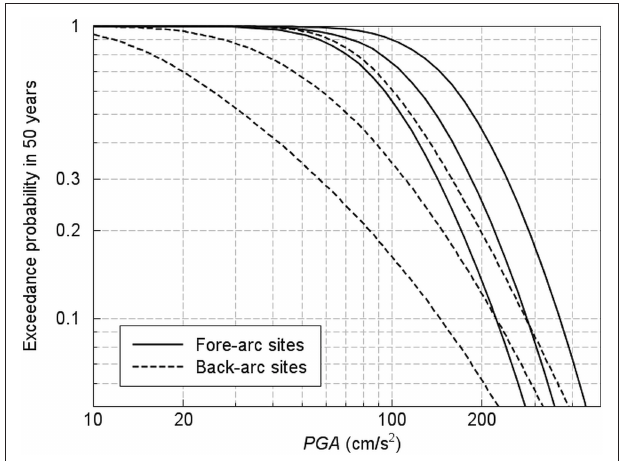
FIGURE 1 | Comparison of hazard curves for PGA for three fore-arc sites and three back-arc